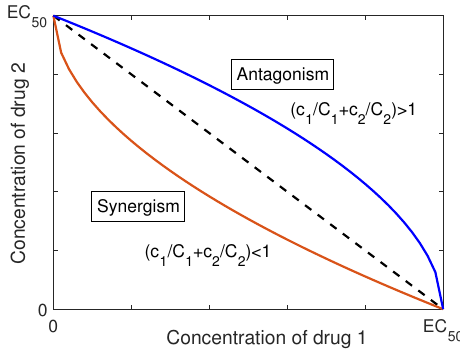
Figure 1. Isobole graph for synergism and antagonism, where the dash line represents the